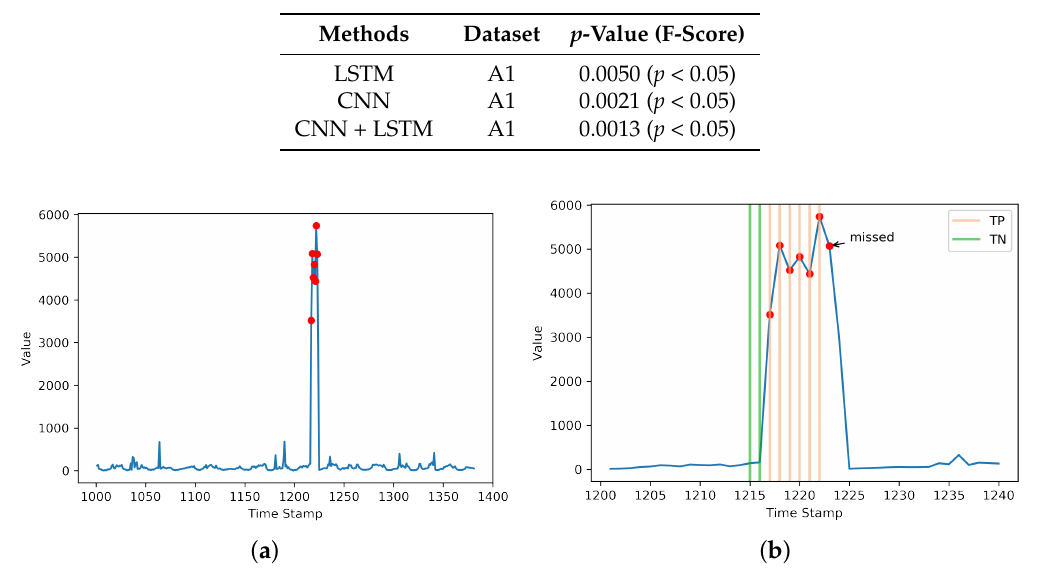
Figure 6. An example test set result on Yahoo dataset. ( a ) shows the time series; true anomalies are highlighted by red markers. ( b ) shows the detection results. Shading in peach and green denotes detections made by